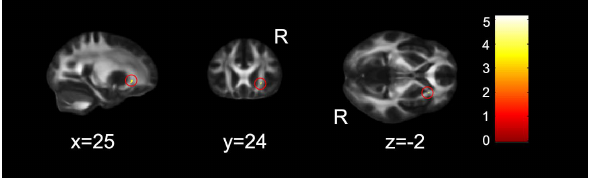
Figure 4. FA skeleton regions where EC ratio scores showed a significant positive correlation with FA maps ( p , 0.05, correct- ed). The region in red circle was identified as the right anterior corona radiata (ACR). The coordinates are in MNI standard space. R, right hemisphere.